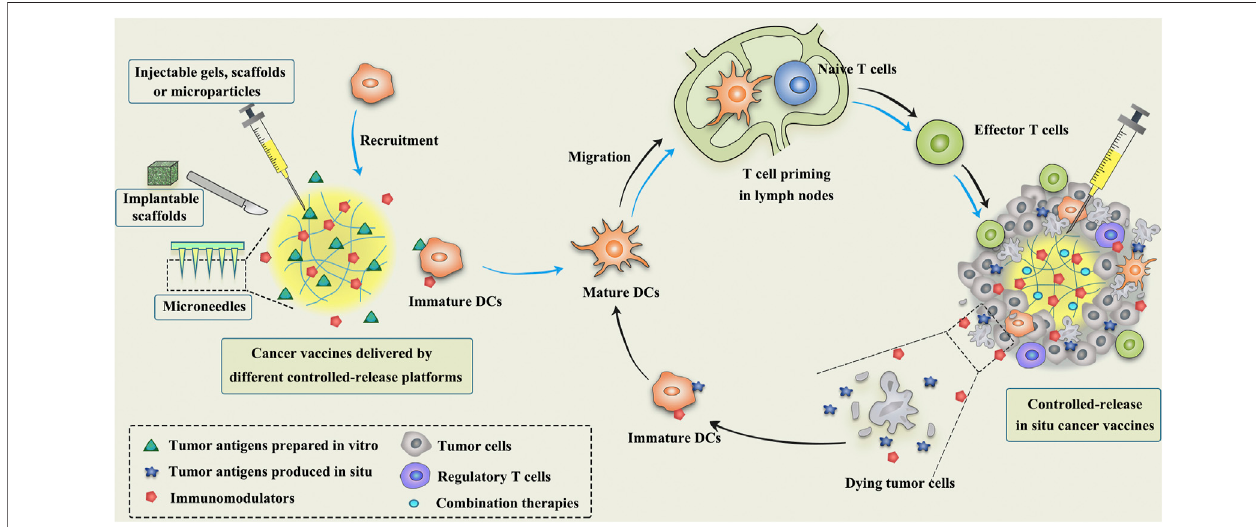
FIGURE 1 | Schematic illustration of the mechanism of controlled-release cancer vaccines for cancer therapy. The blue arrows indicate the antitumor process of conventional cancer vaccines, while the black arrows indicate the mechanism of in situ cancer vaccines.